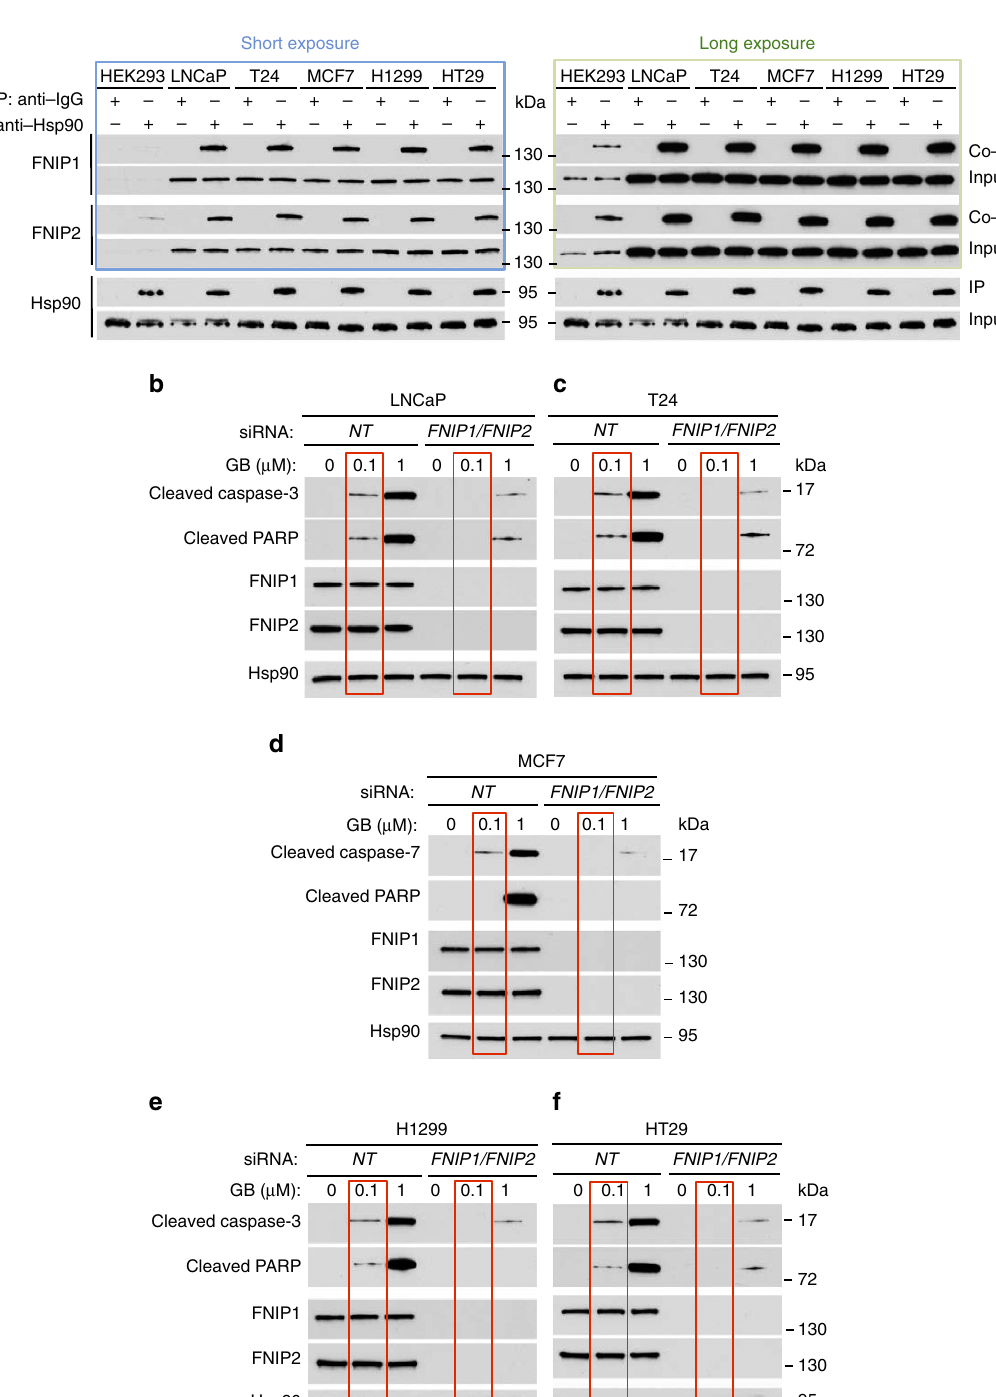
Figure 9 | FNIPs expression sensitizes cancer cells to Hsp90 inhibitor. ( a ) Hsp90 was immunoprecipitated from HEK293 cells and LNCaP (prostate), T24 (bladder), MCF7 (breast), H1299 (lung) and HT29 (colorectal) cancer cell lysates using anti-Hsp90 or IgG (control), and immunoblotted with FNIP1 and FNIP2 antibodies to confirm protein interaction. Short and long exposures of the blots are shown. ( b ) Both FNIP1 and FNIP2 were silenced by siRNA in LNCaP, ( c ) T24, ( d ) MCF7, ( e ) H1299 and ( f ) HT29, and then treated with indicated amounts of GB. Apoptotic markers were shown by immunoblotting using anti-cleaved caspase-3 and cleaved PARP antibodies. Anti-cleaved caspase-7 antibody was only used for MCF7